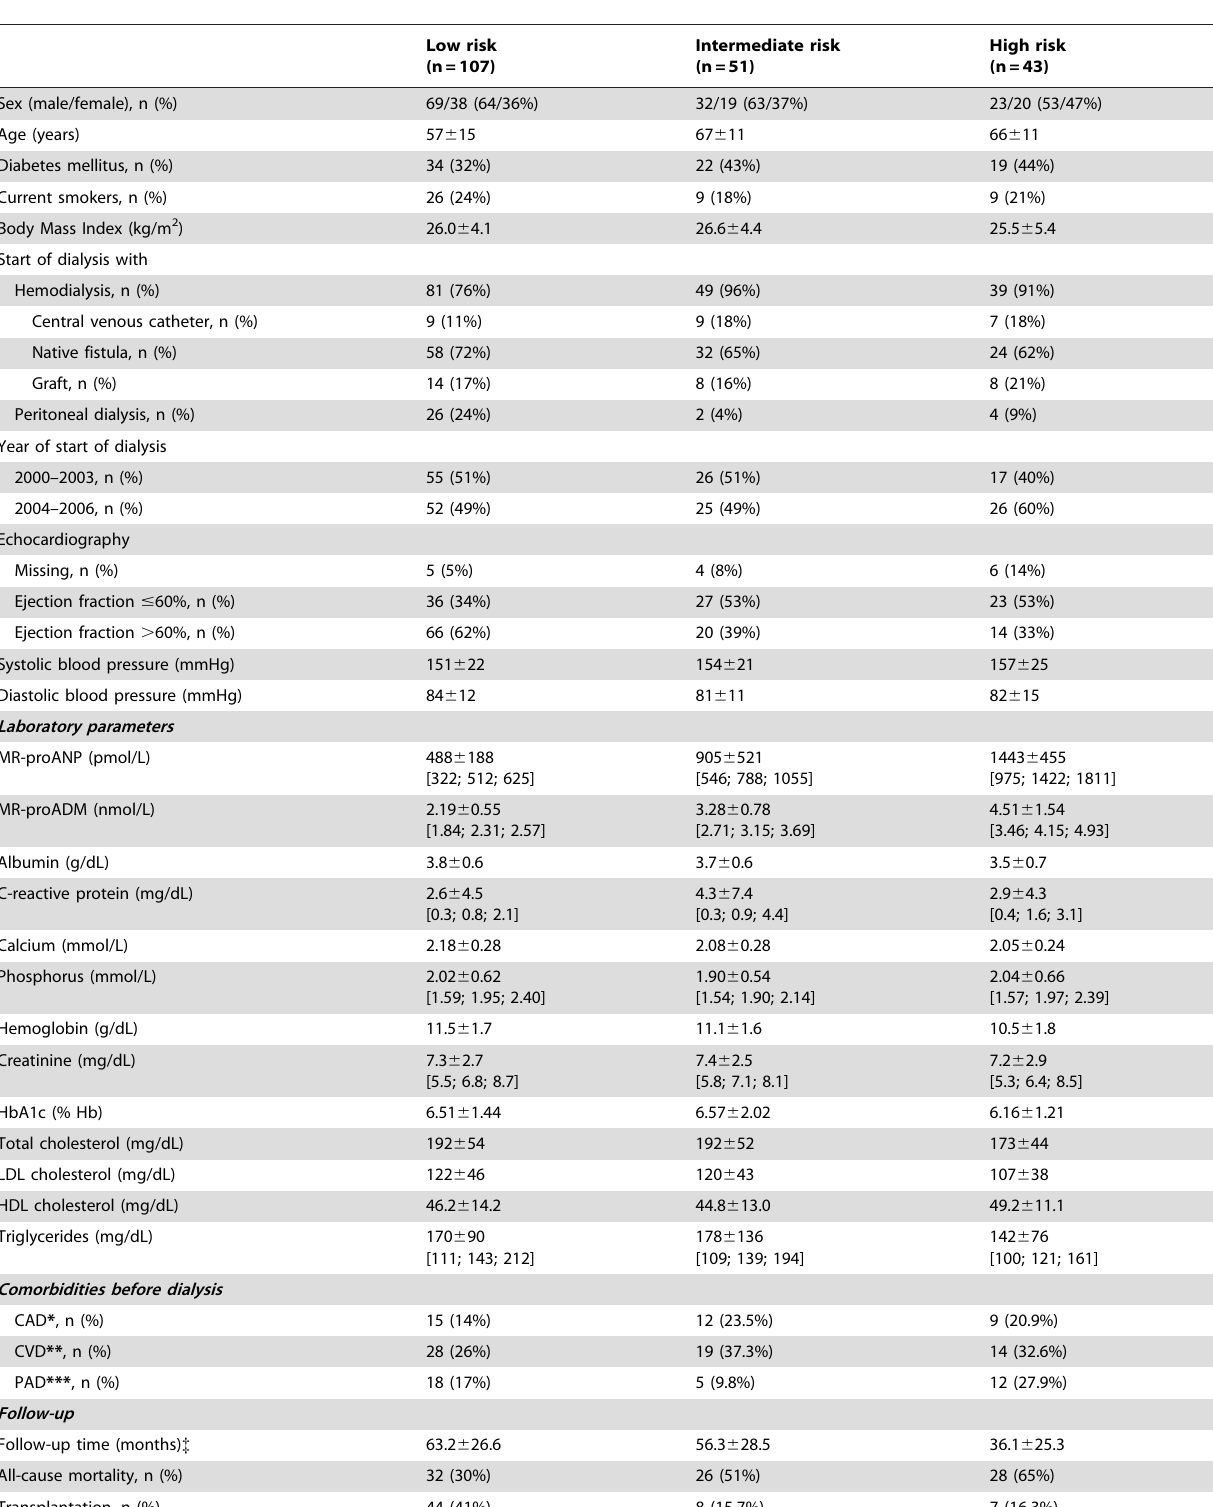
Table 4. Clinical characteristics of patients stratified in high risk (both MR-proANP and MR-proADM in the upper tertile), intermediate risk (only one of the two parameters in the upper tertile) and low risk (none of the two parameters in the upper